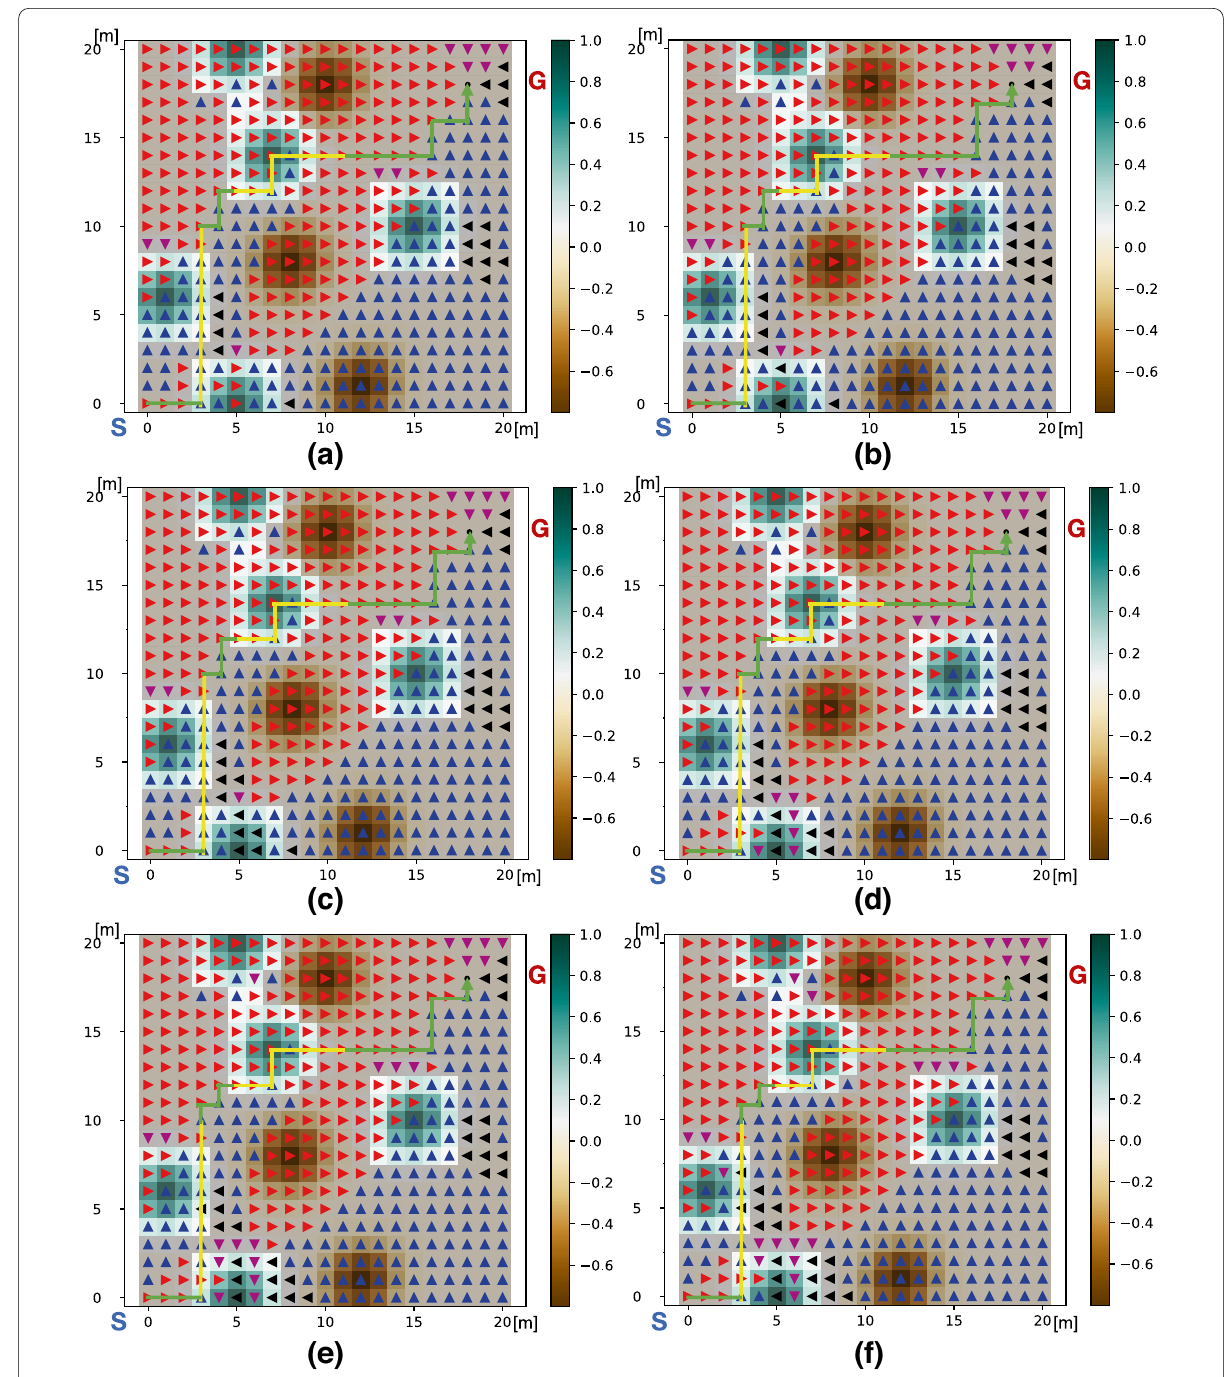
Fig. 8 The path planning results on sandy terrain (1); a : ( w 1 , w 2 ) = ( 0,1 ) , b : ( w 1 , w 2 ) = ( 0.1,0.9 ) , c : ( w 1 , w 2 ) = ( 0.2,0.8 ) , d : ( w 1 , w 2 ) = ( 0.3,0.7 ) , e : ( w 1 , w 2 ) = ( 0.4,0.6 ) , f : ( w 1 , w 2 ) = ( 0.5,0.5